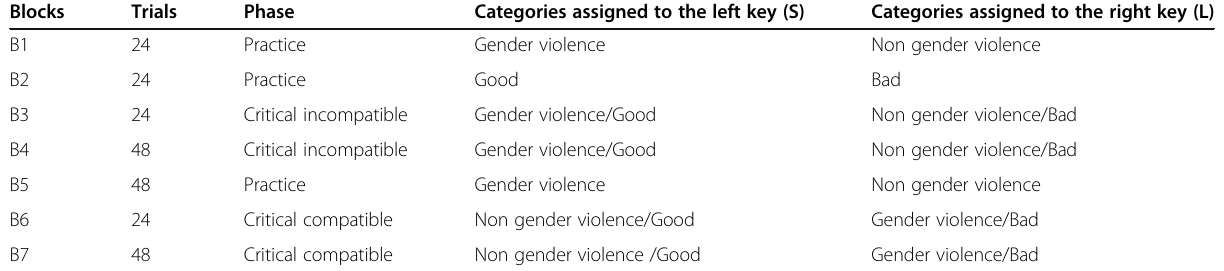
Table 2 Sequence of stimuli presentation initiating the IAT with the incompatible critical phase